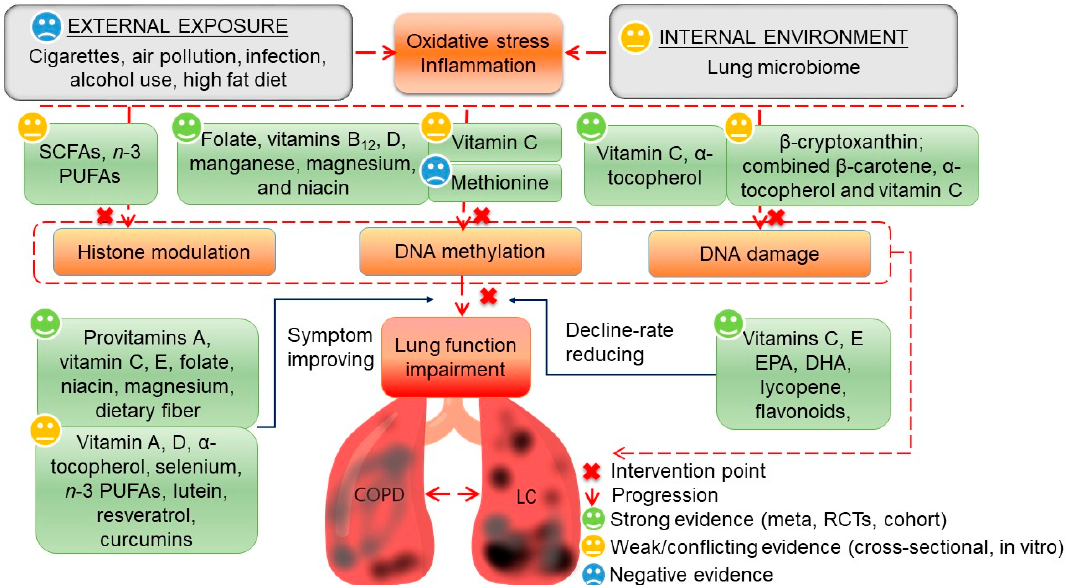
Figure 2. Summary of potential protective micronutrients and phytochemicals in the pathogenesis of chronic obstructive pulmonary disease (COPD) and lung cancer (LC). External and internal factors lead to oxidative stress and inflammation and thus initiate COPD and LC pathogenesis. Interventions against external exposure are not satisfying, while targeting the lung microbiome is promising. Recent studies have revealed strong evidence on protective nutrients in DNA methylation and damage but studies on histone modulation are limited to animal or cell experiments. Epidemiological studies about micronutrients and phytochemicals in later key event lung function impairment are abundant, and have identified different intervention patterns, including symptom improvement and a decline rate-reducing pattern. PUFA: polyunsaturated fatty acid; EPA: eicosapentaenoic acid; DHA: docosahexaenoic acid; SCFA: short-chain fatty acid; RCT: randomized controlled trials.